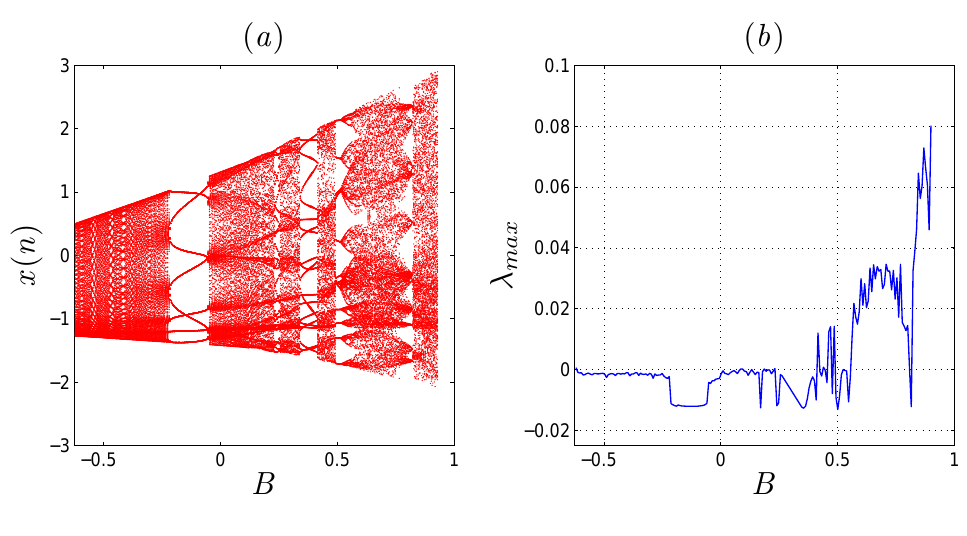
Figure 2. ( a ) The bifurcation diagram versus B , when A = 0.7, γ = 0.998 and let n = 1500. ( b ) The LLE in accordance with diagram ( a